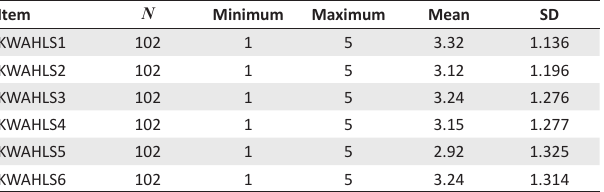
TABLE 9: Descriptive statistical analysis (Section B – keeping work and home life separate).